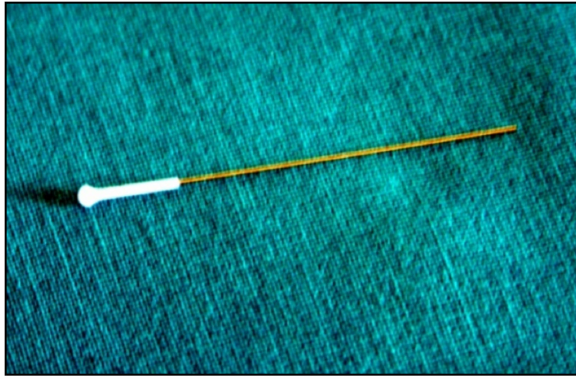
Figure 12. Disposable iCare